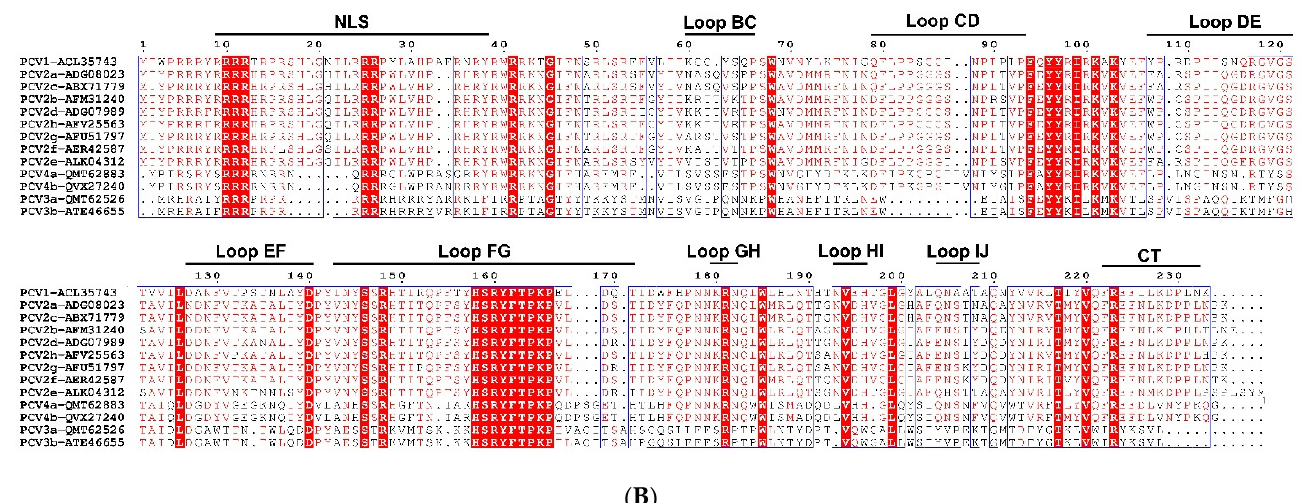
Figure 1. Sequence characteristics of PCV. ( A ) Genomic characteristics. The unique sequence of PCV1, PCV2, PCV3, and PCV4 were labeled green, red, gray, and blue, respectively. The conserved motif was marked by yellow. ( B ) Amino acids sequence alignment of PCV Capsid. The amino acid sequence alignments were performed with an online tool (https://www.genome.jp/tools-bin/clustalw, accessed on 5 April 2022) and shown by Espript 3.0 (https://espript.ibcp.fr/ESPript/cgi-bin/ESPript.cgi, accessed on 5 April 2022). The NLSs of Cap protein were predicted with NLStradamus (https://www.novopro.cn/tools/nls-signal-prediction.html, accessed on 5 April 2022). Moreover, loop regions of Cap protein were predicted with SOPMA (https://npsa-prabi.ibcp.fr/cgi-bin/npsa_automat.pl?page=/NPSA/npsa_sopma.html, accessed on 5 April 2022).